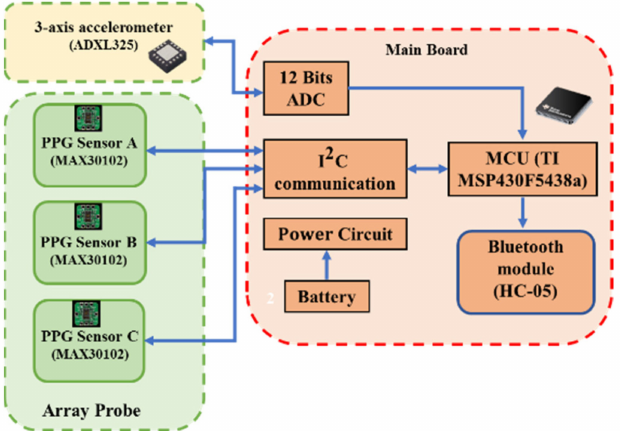
Figure 2. The block diagram of the light reflection rheography (LRR) wearable device consisting of an array-type probe, accelerometer, and main board. PPG is the photoplethysmography, MCU the microcontroller unit. and ADC the analog to digital converter.